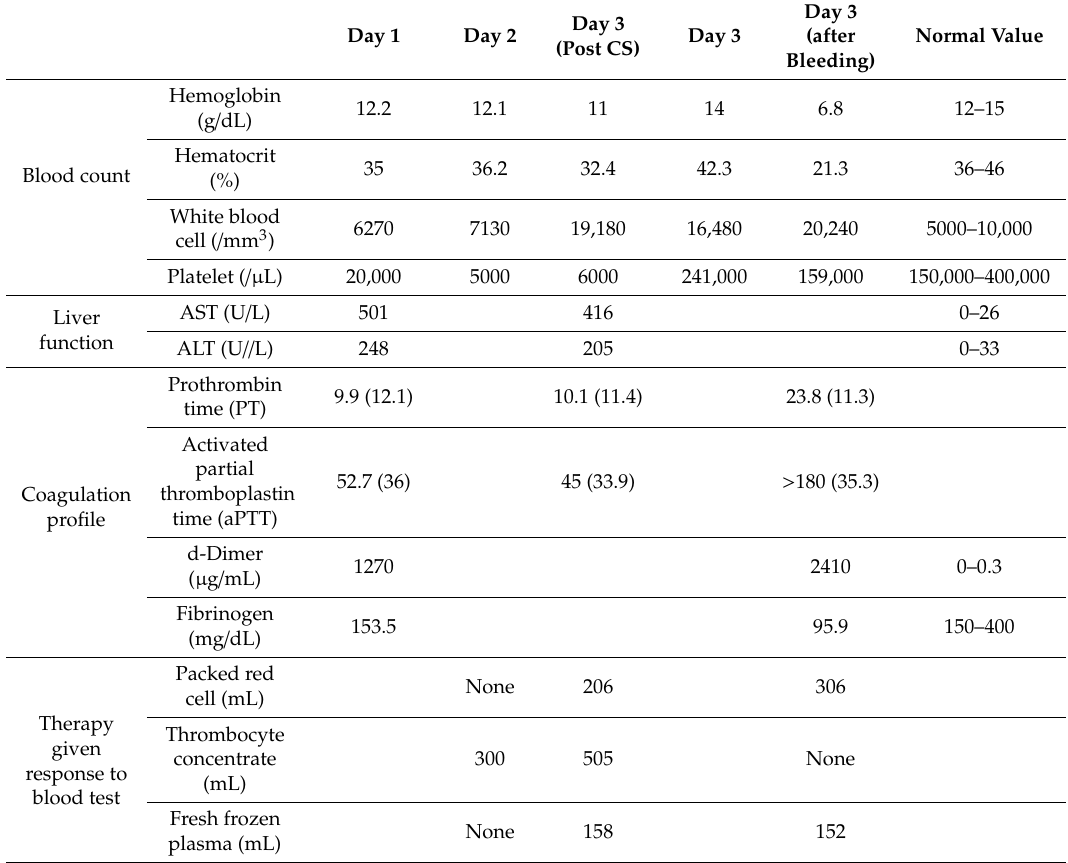
Table 4. Daily laboratory trend and therapy.